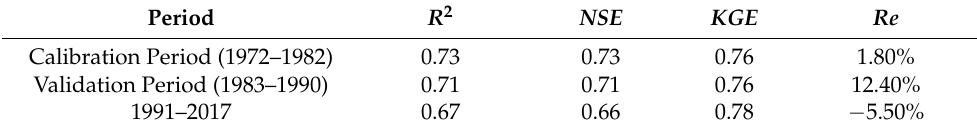
Table 4. Evaluation results of daily runoff simulation at Shiquan hydrological